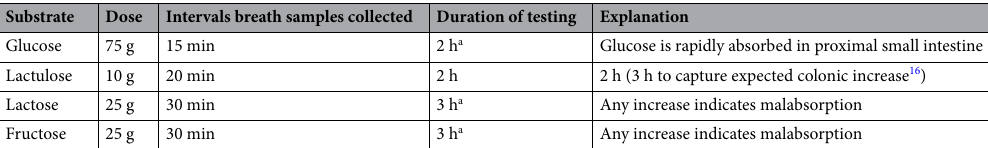
Table 1. Conducting breath tests using various substrates 8 . a Test may be terminated earlier, if a peak above baseline is